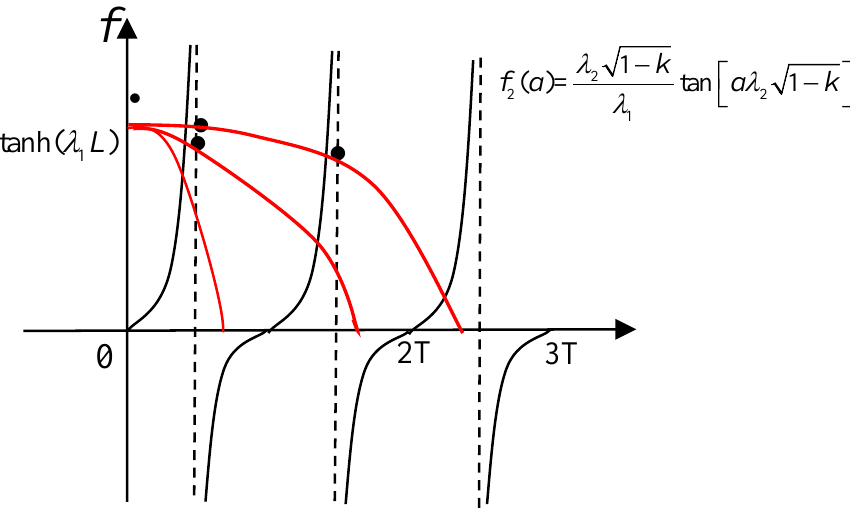
The two functions are plotted on the a-f plane in Figure 18. The number of solutions to f 1 ( a ) = f 2 ( a ), namely, the intersection points between them, is dependent on the value of L and T. It is not difficult to find that for ( n − 1)T< L ≤ n T where n is a positive integer, there are n number of intersection points in the range [0, L ].